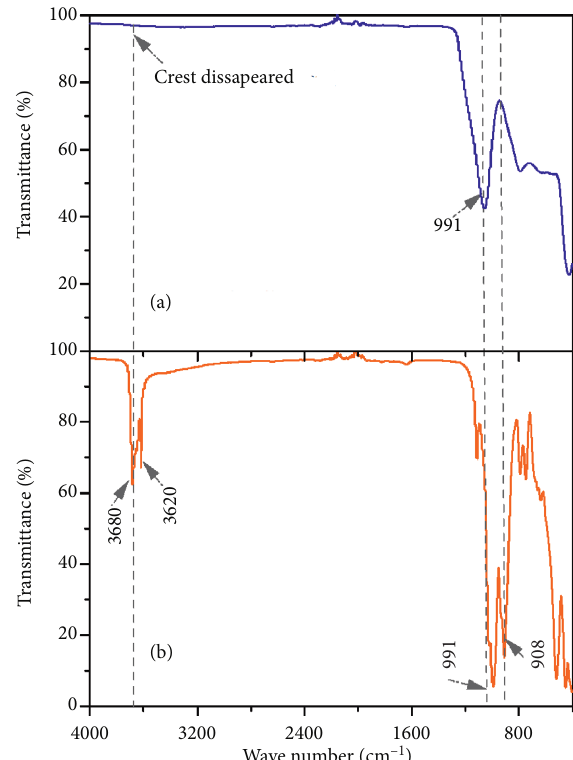
Figure 6: Infrared spectra of (a) metakaolin and (b)